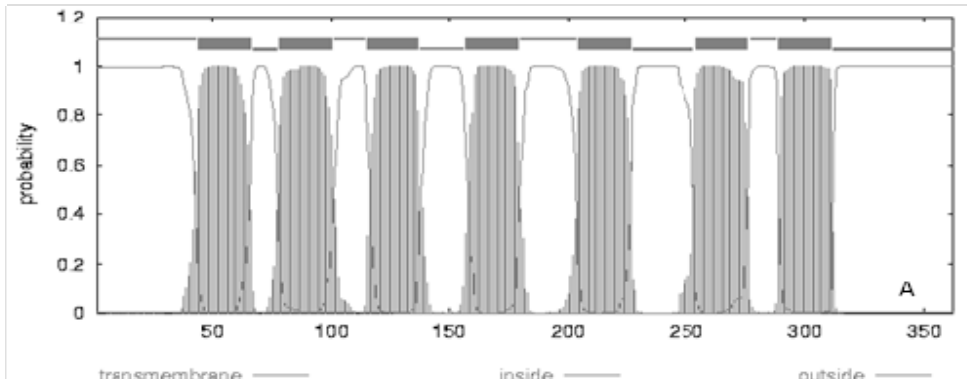
Figure 1. Seven-transmembrane structure of typical melatonin receptors from most vertebrate species (panel A ), and deviations of cat MTNR1A (panel B ) and GPR50 (panel C ). Sequences were examined by a transmembrane protein topology prediction method based on a hidden Markov model (TMHMM) [55] for the presence of seven trans-membrane